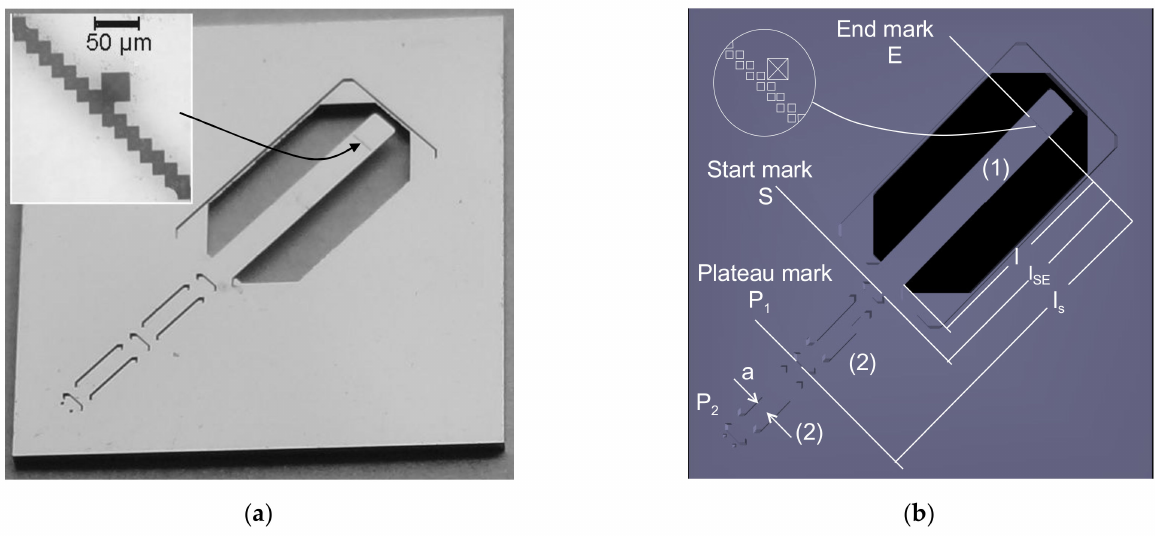
Figure 1. Description of the microforce cantilever chips [26]: ( a ) View on an etched silicon cantilever chip as a force standard (cantilever parallel to <100>-direction) with zoomed view of the end mark E ; ( b ) Designation of the